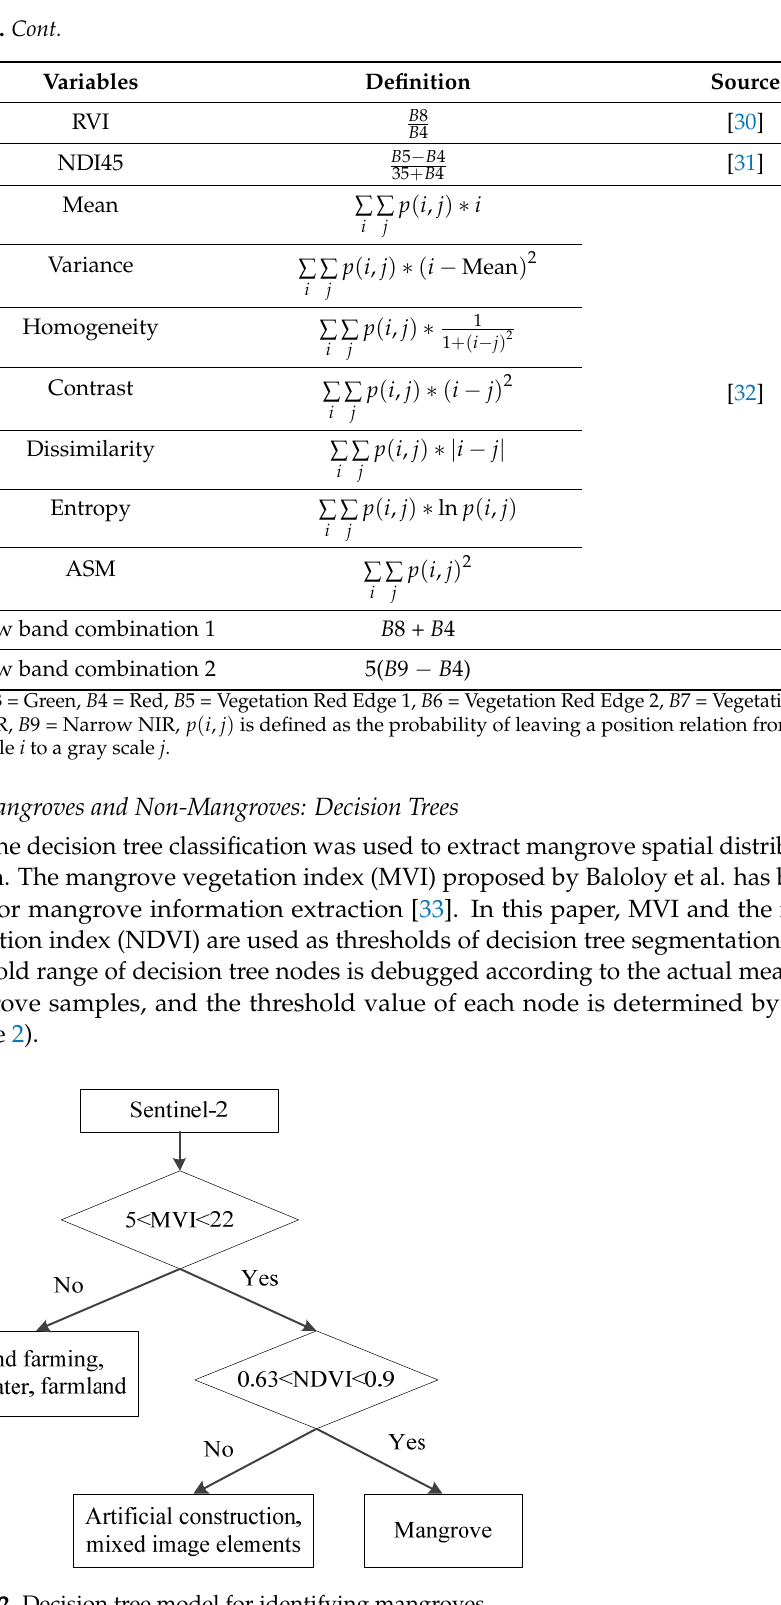
Figure 2. Decision tree model for identifying